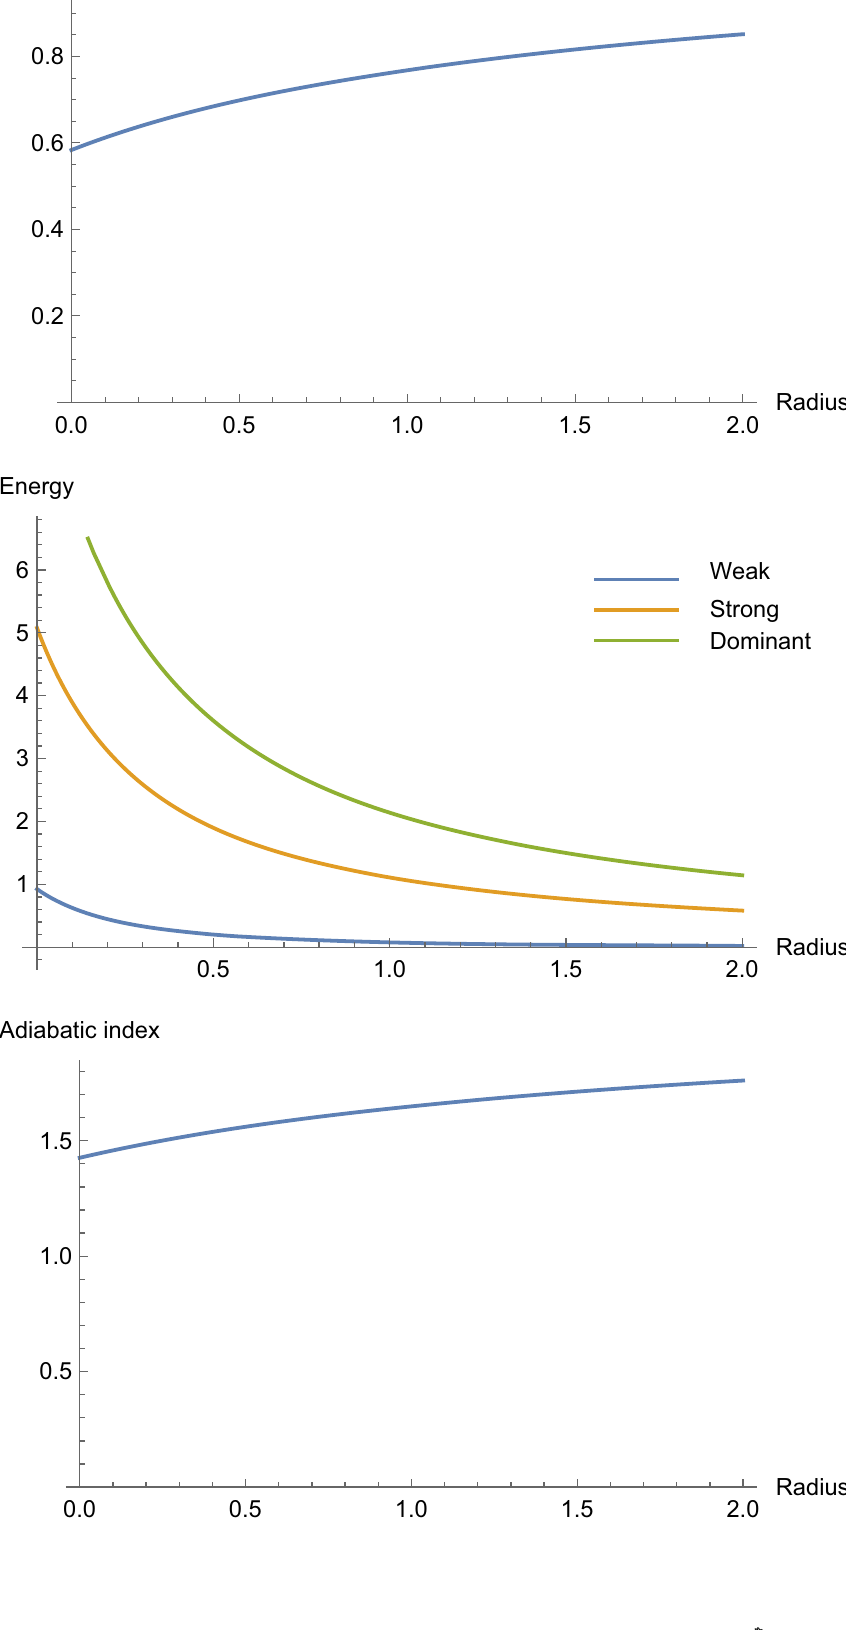
Fig. 13 Square of sound speed dp versus the radial variable x d ρ